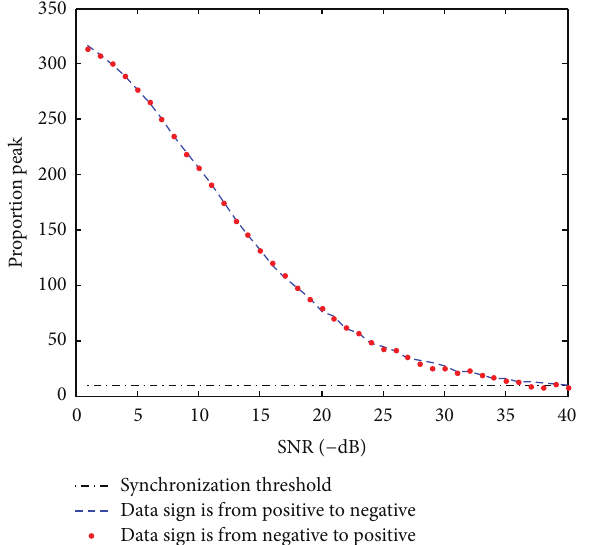
Figure 6: The estimated reversal error change with changing SNR.